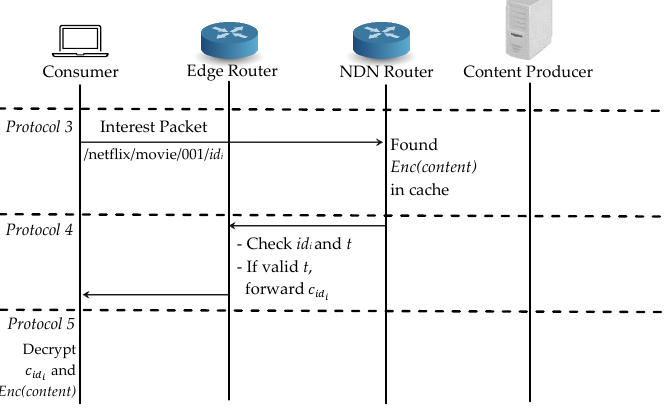
Figure 6. Proposed scheme: Case (2) the same consumer requests the same content.